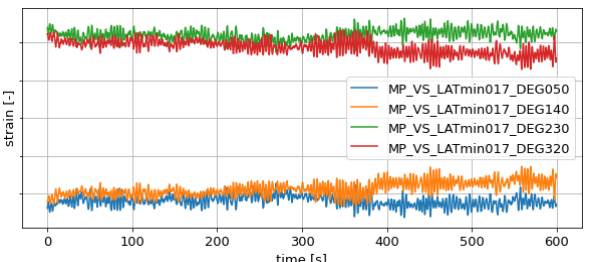
Figure 9. Strain measurement and corresponding estimation for a specific location on the monopile (here aligning with a sensor location for validation) at − 17 m LAT . As the contribution of the normal force N is omitted, an offset appears but dynamic strains are correctly